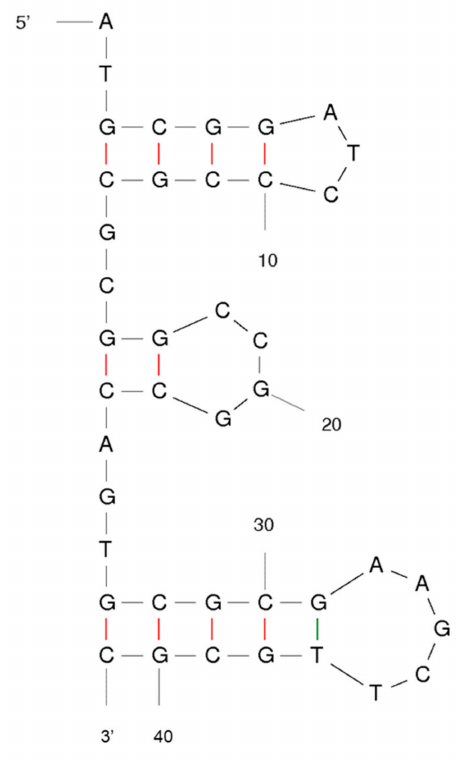
Figure 1. The secondary structures of candidate aptamer NP7.